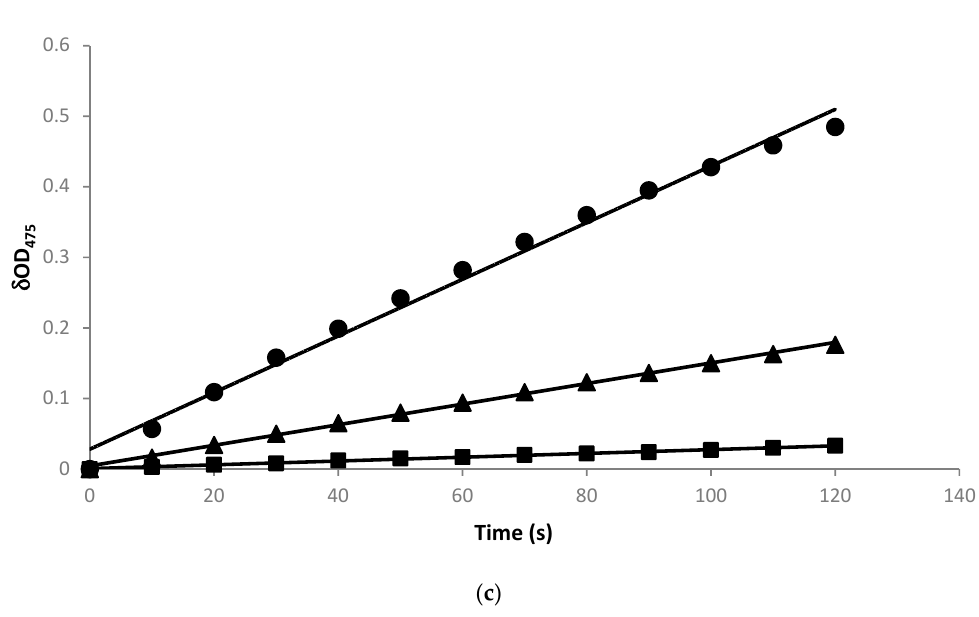
Figure 1. Construction and expression of B. megaterium tyrosinase in E. coli . ( a ) Map of the expression vector pETDuet-BmTYR. ( b ) Sodium dodecyl sulfate polyacrylamide gel electrophoresis (SDS-PAGE) of recombinant E. coli harboring pETDuet-BmTYR. Crude proteins from whole cell lysis with 0 h induction (lane 1), 4 h induction (lane 2), and 24 h induction (lane 3) were separated using SDS-PAGE. Arrows indicate the expressed tyrosinase. M represents the molecular weight markers. ( c ) Tyrosinase activity assay using L -DOPA as substrate. Either 20 μ g ( ─ ￭ ─ ), 100 μ g ( ─ ▲ ─ ), or 400 μ g ( ─ ● ─ ) of the lyophilized recombinant cells was mixed with 2.5 mM of L -DOPA in 1 mL phosphate-buffered saline (PBS, pH 6.8) and the resulting dopachrome was monitored at 475 nm with a spectrophotometer. One unit of tyrosinase activity is the amount of cells that produces one μ mole of dopachrome (absorption efficiency ε = 3600 cm − 1 M − 1 ) per minute from the reaction.